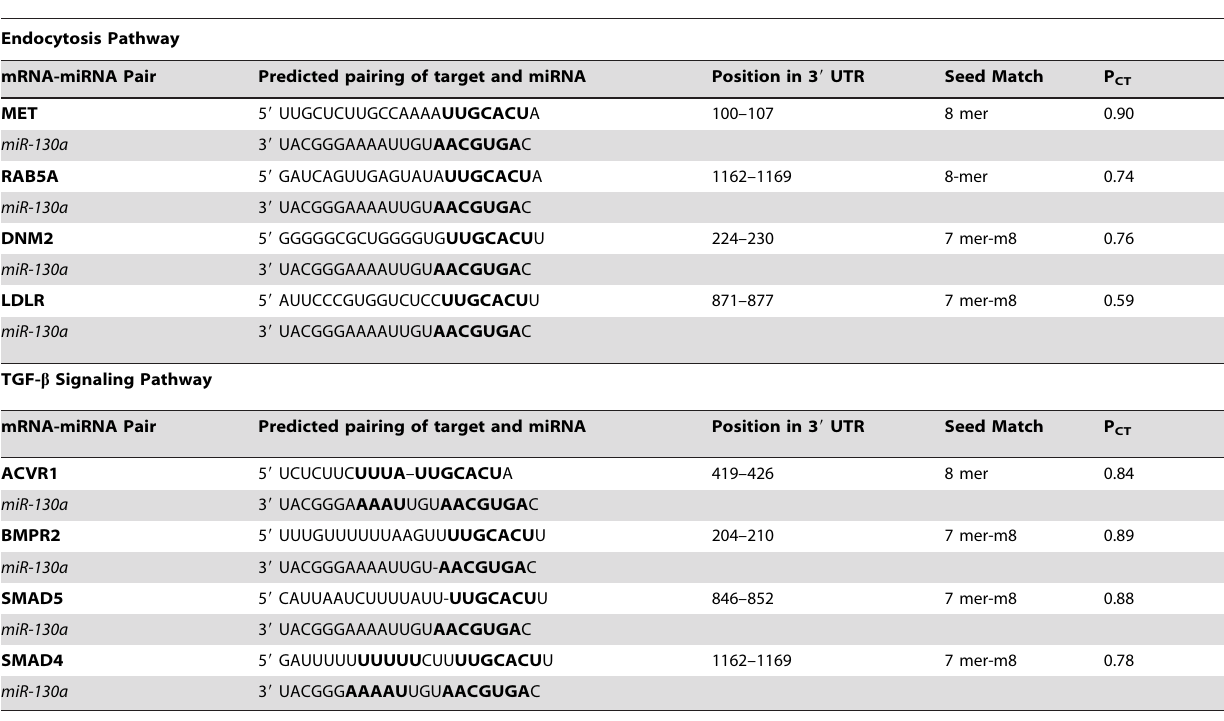
Table 3. Location of putative miR-130a binding sites in the 3 9 UTR of target